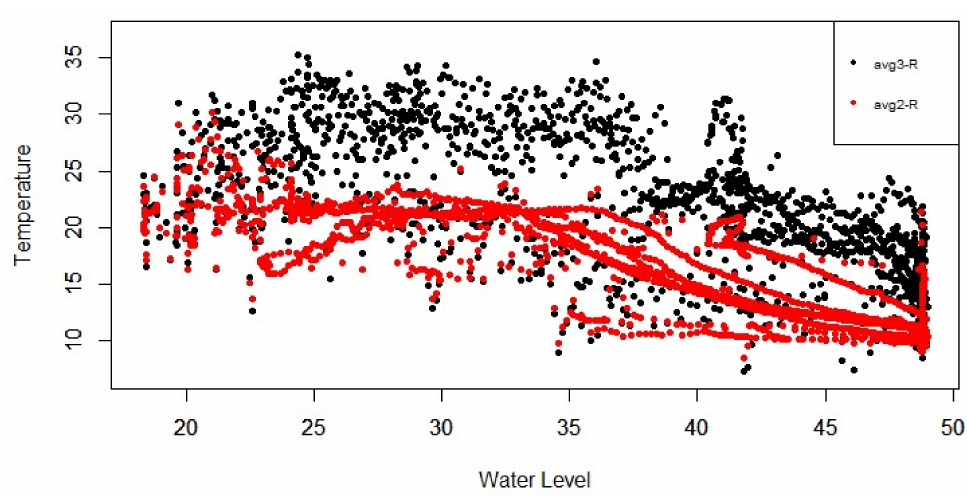
Figure 23. Water level (m) against avg2-R and avg3-R water temperatures ( ◦